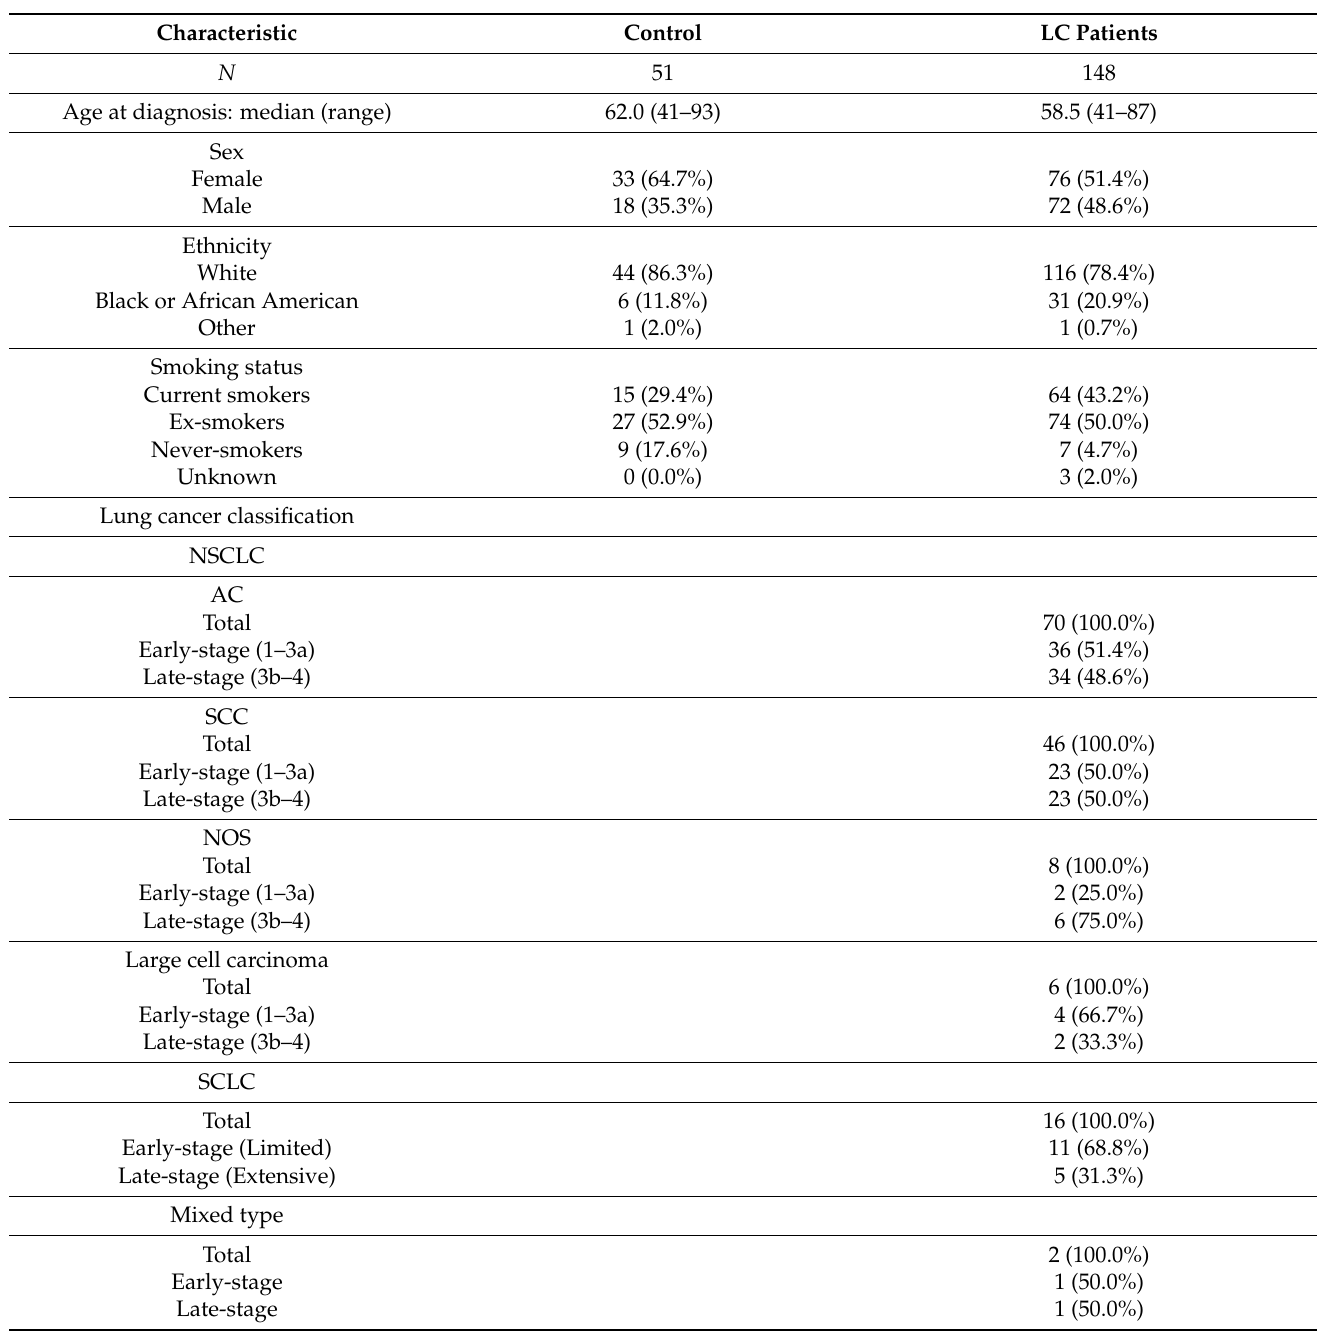
Table 1. Demographic and clinical characteristics of control subjects and lung cancer patients included in the DSC analysis. Characteristic Control LC Patients N 51 148 Age at diagnosis: median (range) 62.0